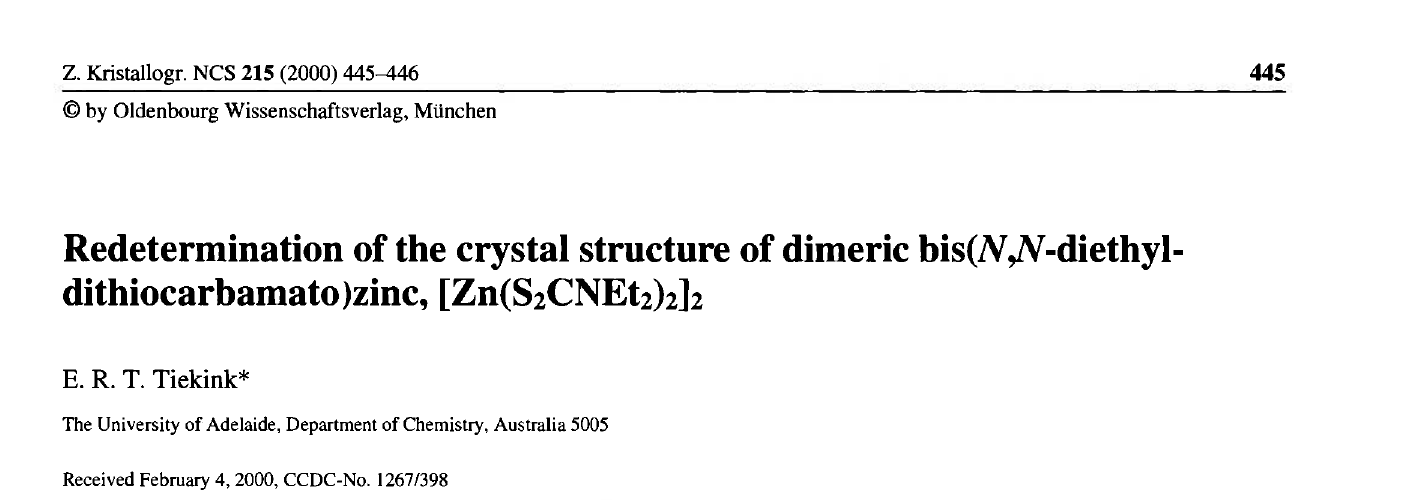
Table 1. Data collection and handling.